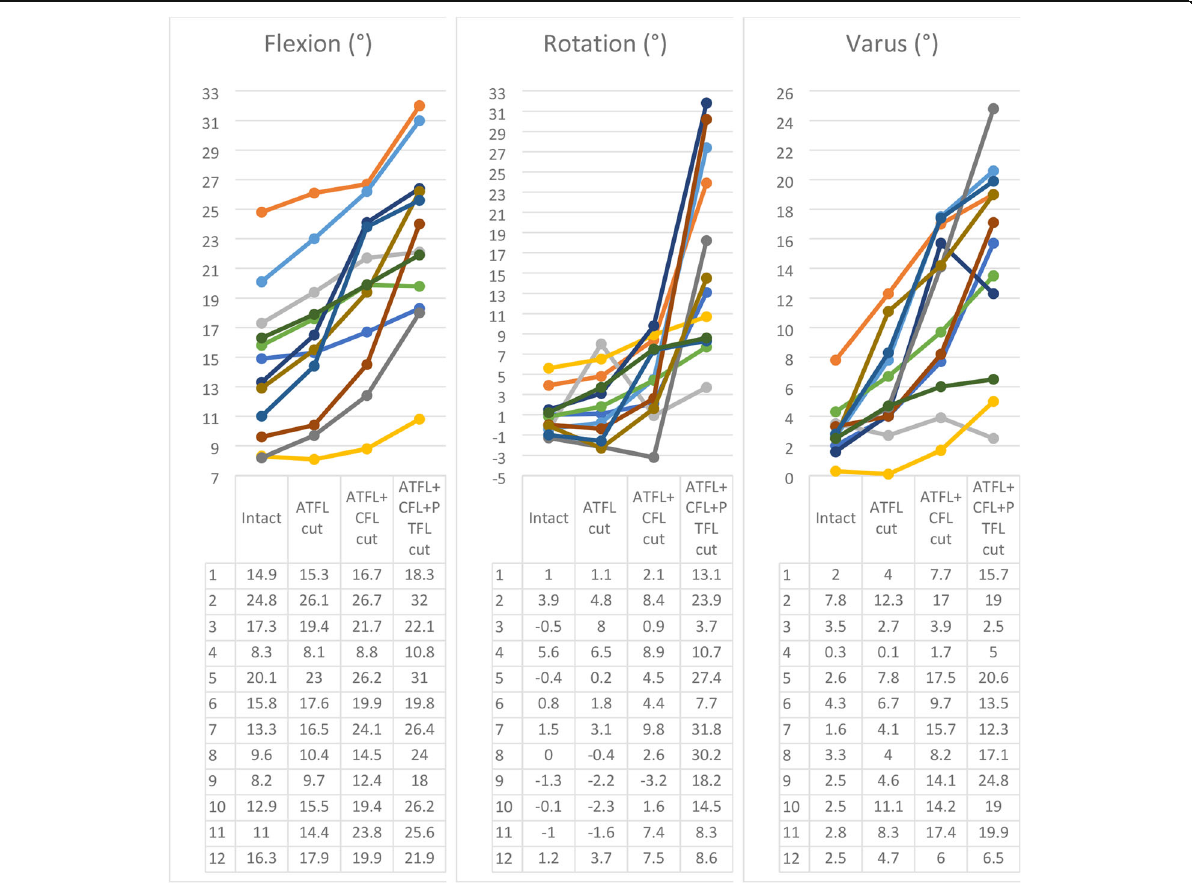
Fig. 7 Amount of flexion, rotation and varus exhibited by the foot after sequential